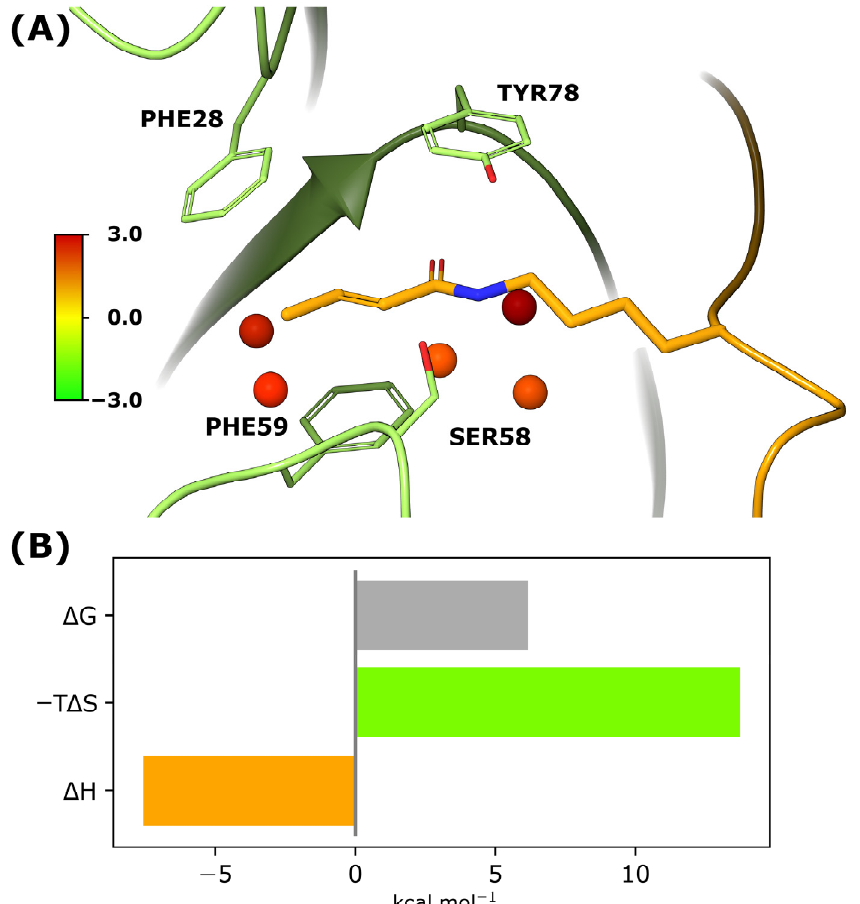
Figure 4. Thermodynamics of water molecules inside the aromatic pocket of the AF9 YEATS domain. ( A ) Identified hydration sites at the methacryllysine/crotonyllysine binding pocket of AF9 YEATS, determined by GIST. ( B ) Approximated solvation energy terms at the methacryllysine/crotonyllysine binding pocket of AF9